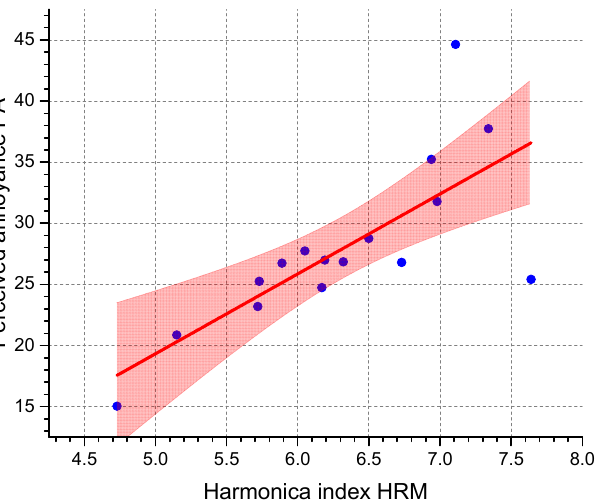
Figure 5. Harmonica index HRM and perceived annoyance PA determined to evaluate the poten- tial annoyance in the wards. The colored area around the regression line corresponds to the 95% confidence interval.